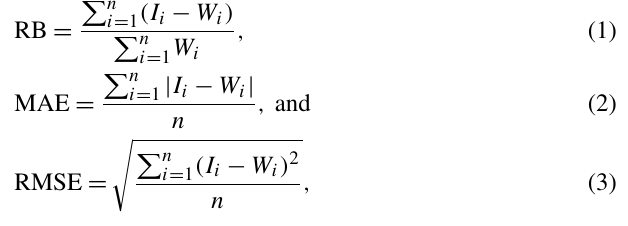
Figure 2. WEGN network-averaged half-hourly rainfall amounts as function of the number of WEGN gauges detecting rain (gauges with ≥ 0.1mm rainfall are counted). The rain amounts for half- hourly time intervals over the study period (April–October in 2014– 2015) are shown, to check the reasonability of a rain/no-rain thresh- old for the IMERG data evaluation; 0.05mm is used for the study. The inset shows the full range of rainfall